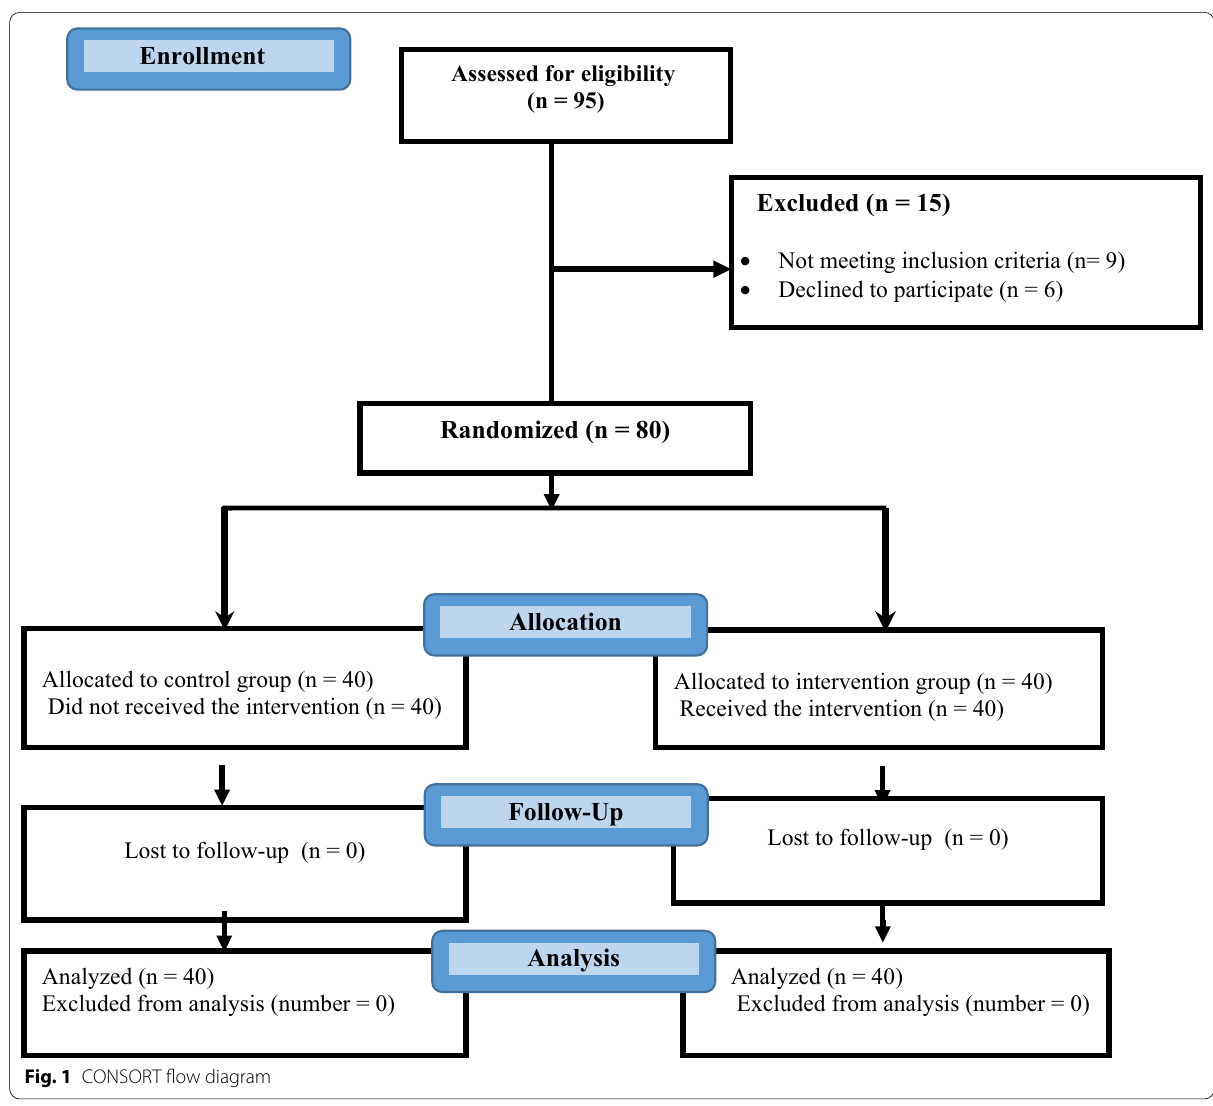
Fig. 1 CONSORT flow